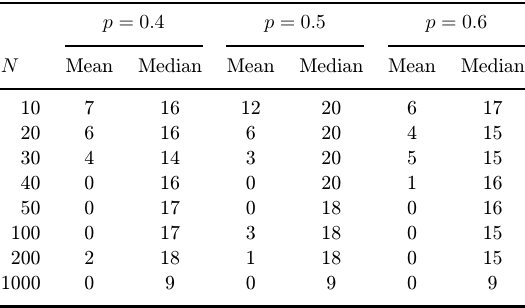
Table 3. Results based on 20 predictions for k ¼ 256 , m ¼ 64 , and s ¼ 20 .